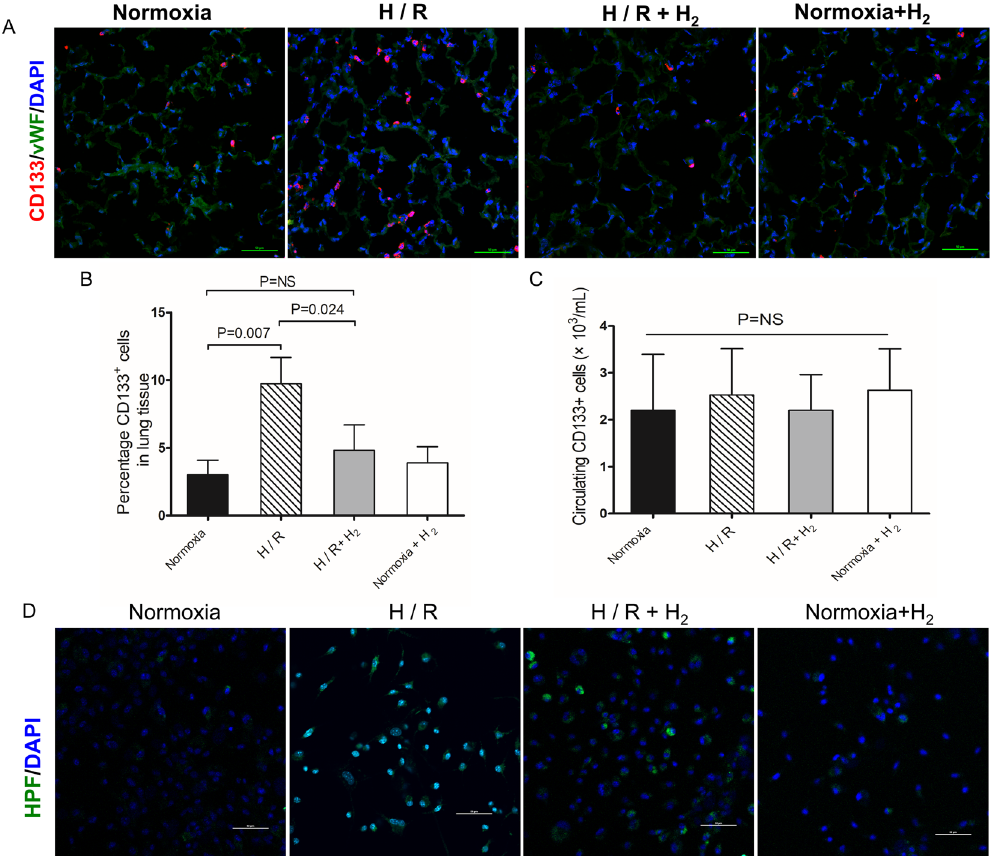
Figure 7. Effect of hydrogen on CD133 + progenitors. Mice were treated as described in Fig. 1 (n = 4 in each group). Lung samples were harvested for CD133 + cell staining ( A ) and counting ( B ). Blood samples were extracted and CD133 + cells were counted ( C ). ( D ) Cultured CD133 + progenitors were stained with hydroxyphenyl fluorescein solution and DAPI. Scale bar, 50 μ m. Data shown are mean ± SEM. ns, not